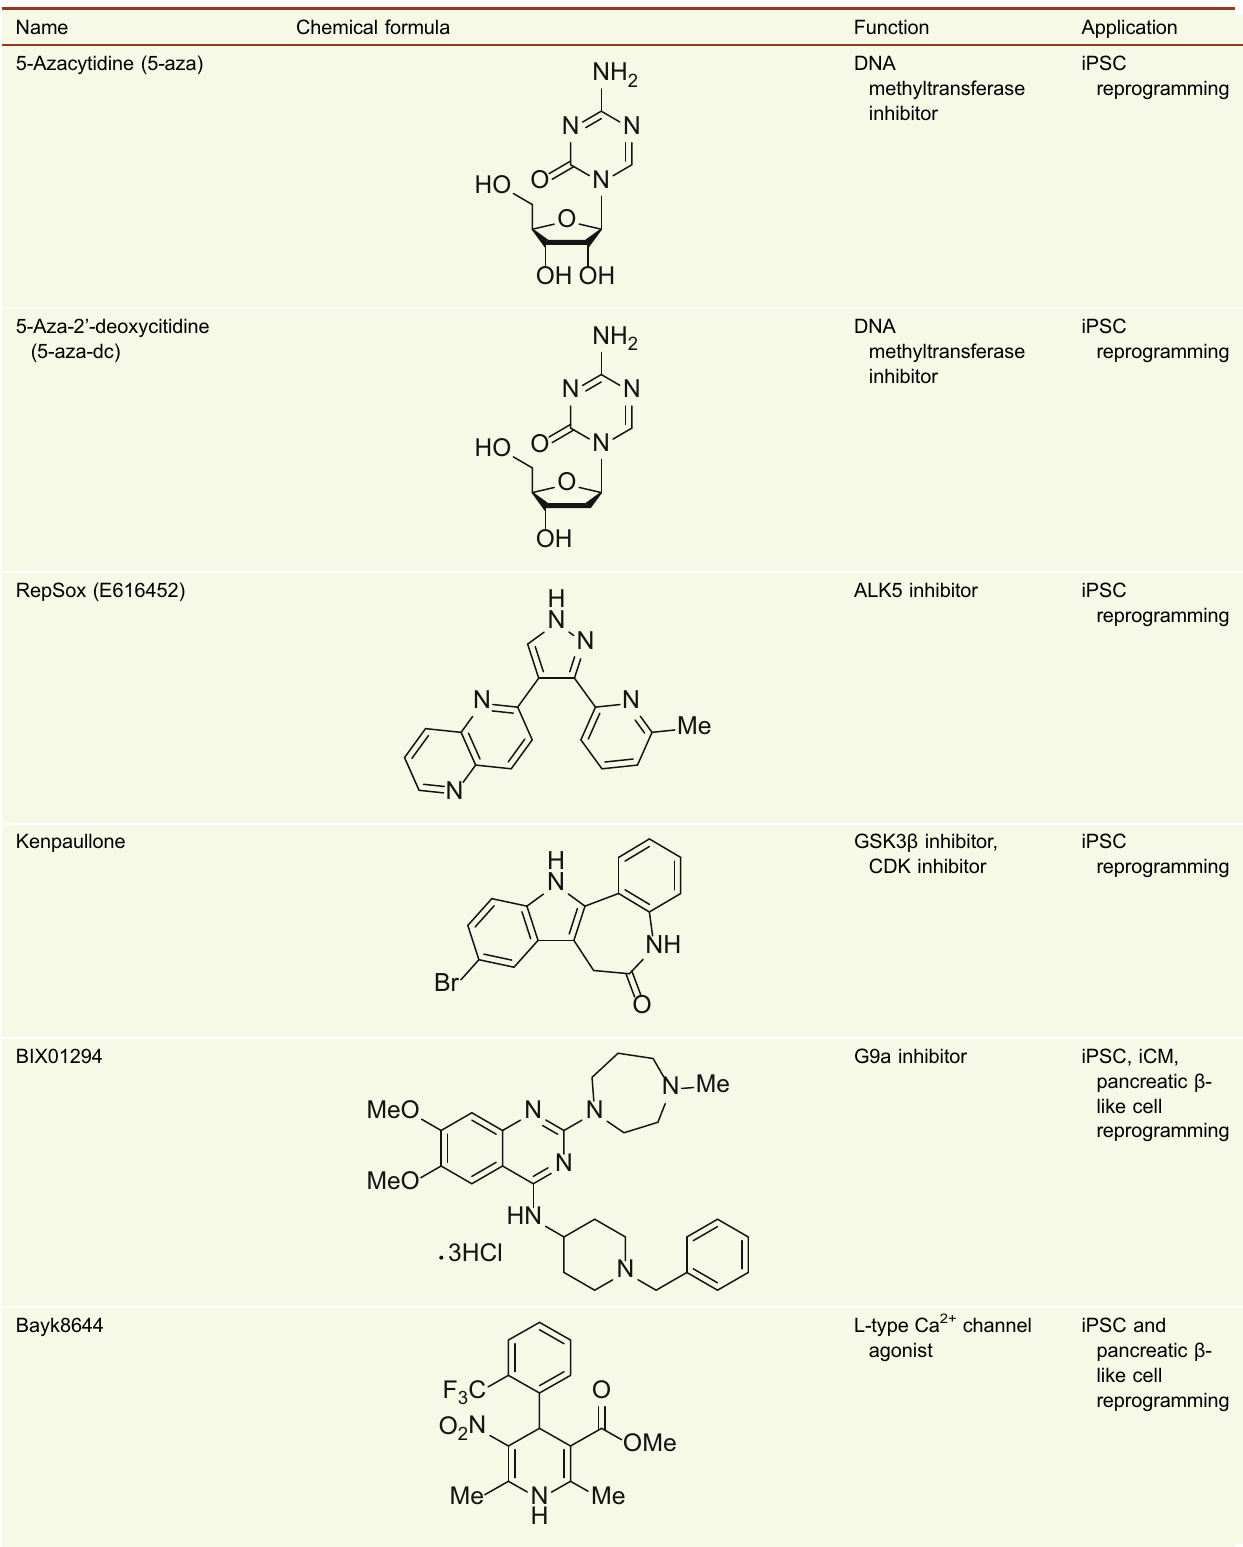
Table 1. Representative small molecules for reprogramming cell